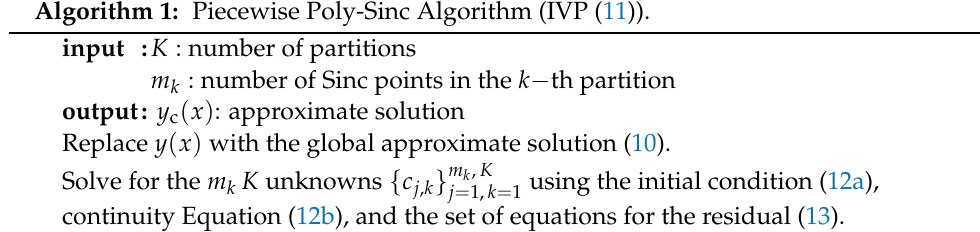
Algorithm 1: Piecewise Poly-Sinc Algorithm (IVP